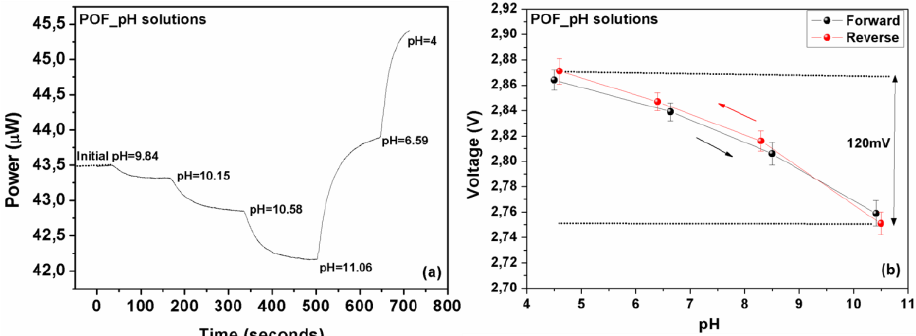
Figure 8. ( a ) Measured optical response of the polymer optical fiber sensor standard pH